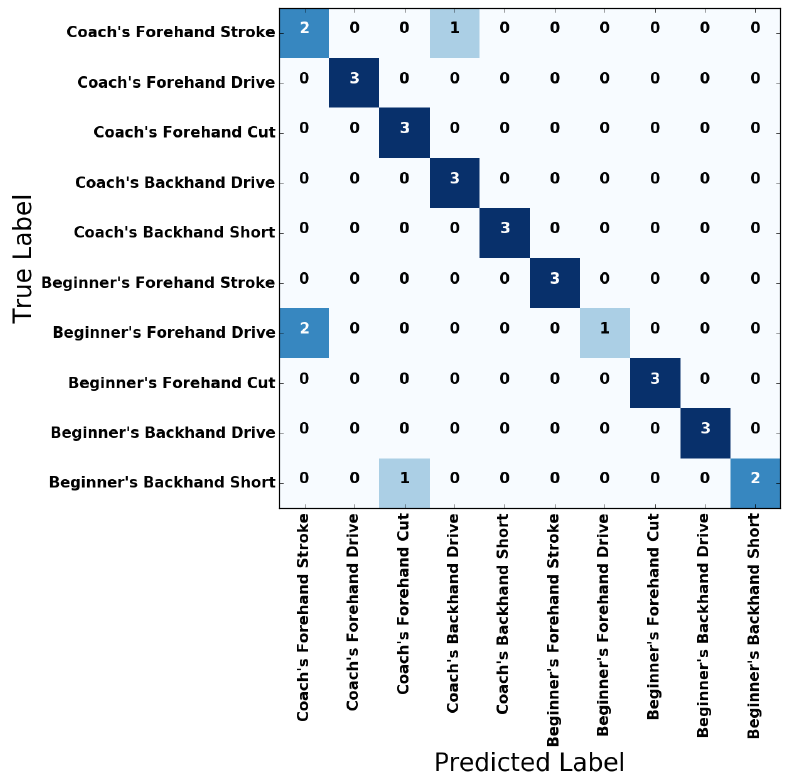
Figure 9. Confusion matrix of the two-stacked unidirectional LSTM RNN